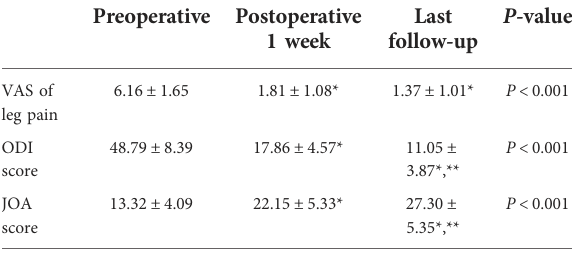
TABLE 3 VAS of leg pain, ODI score and JOA